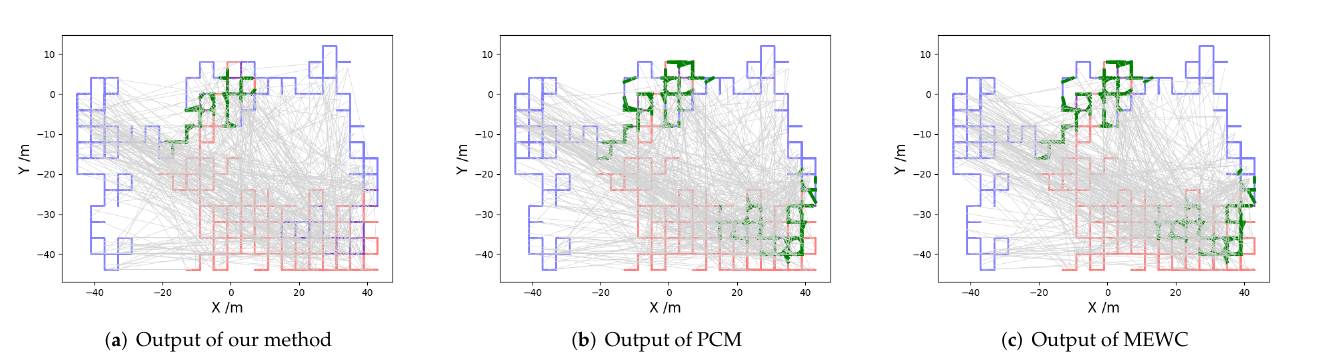
Figure 6. Results for manhattan dataset estimated by our method, PCM, and MEWC, in presence of 500 outliers. Final optimized map in red, correctly accepted inlier constraints are green, disabled outliers in gray.